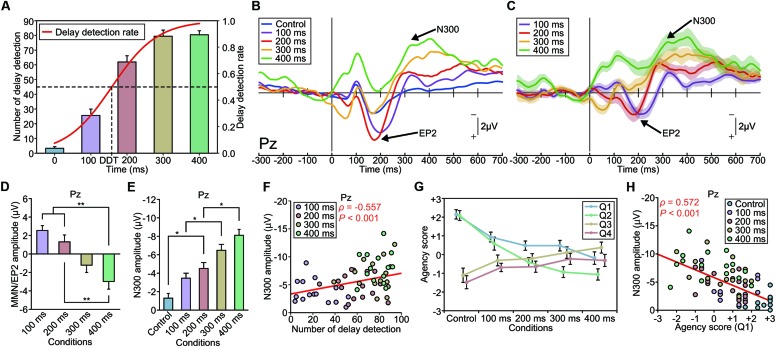
Modulation of the EP2 and N300 by delay length (Experiment 4). (A) The number of auditory feedback delays that the participant detected increased as a function of the delay length. Delay detection probabilities were fitted to a logistic function. The delay detection threshold (DDT), where the probability is 50%, was estimated to be 158 ms. (B) Grand-averaged ERP waveforms at Pz (n = 16). Deviant auditory feedback was delayed by either 0 ms (control), 100, 200, 300, or 400 ms, with each delay size presented in a separate session. (C) Differential (deviant – standard) ERP waveforms. Shaded areas represent SEM. (D) The amplitude of the EP2 (MMN) was significantly modulated by the delay length. A one-way ANOVA revealed a main effect of delay [Pz: F(3,60) = 10.70, p < 0.001, effect size η2 = 0.35]. A post hoc analysis (Tukey’s HSD test) revealed a significant difference between the 100/200-ms-delay and 400-ms-delay conditions. Notably, the P2 was enhanced in the shorter-delay (≤200 ms) conditions while the MMN was present in the longer-delay (≥300 ms) conditions. (E) The amplitude of the N300 was significantly modulated by the delay length [Pz: F(4,75) = 18.30, p < 0.001, effect size η2 = 0.49]. A post hoc analysis (Tukey’s HSD test) indicated that the absolute amplitude of the N300 was significantly larger in the 300 and 400-ms-delay conditions compared with the other conditions. (F) The N300 amplitude was significantly correlated with the rate of subjective detection of the auditory feedback delay. A correlation analysis showed a significant correlation between the amplitude of the N300 at Pz and the counted number of delayed stimuli (ρ = -0.557, p < 0.001, Spearman’s rank correlation coefficient). (G) We assessed the sense of agency via a questionnaire: Q1 and Q2 concerned the sense of agency, while Q3 and Q4 served as dummy questions (see Materials and Methods). The sense of agency was attenuated as the delay length increased. A one-way ANOVA revealed a significant effect of the delay [Q1: F(4,75) = 9.22, p < 0.001, effect size η2 = 0.33; Q2: F(4,75) = 18.91, p < 0.001, effect size η2 = 0.50]. A post hoc analysis exposed significant differences between the shorter-delay conditions and the longer-delay conditions. (H) A correlation analysis revealed a significant correlation between the amplitude of the N300 at Pz and the agency score (Q1: ρ = 0.572, p < 0.001, Spearman’s rank correlation coefficient). A similar result was obtained for Q2 (ρ = 0.545, p < 0.001). ∗p < 0.05, ∗∗p < 0.01. Error bars represent SEM.